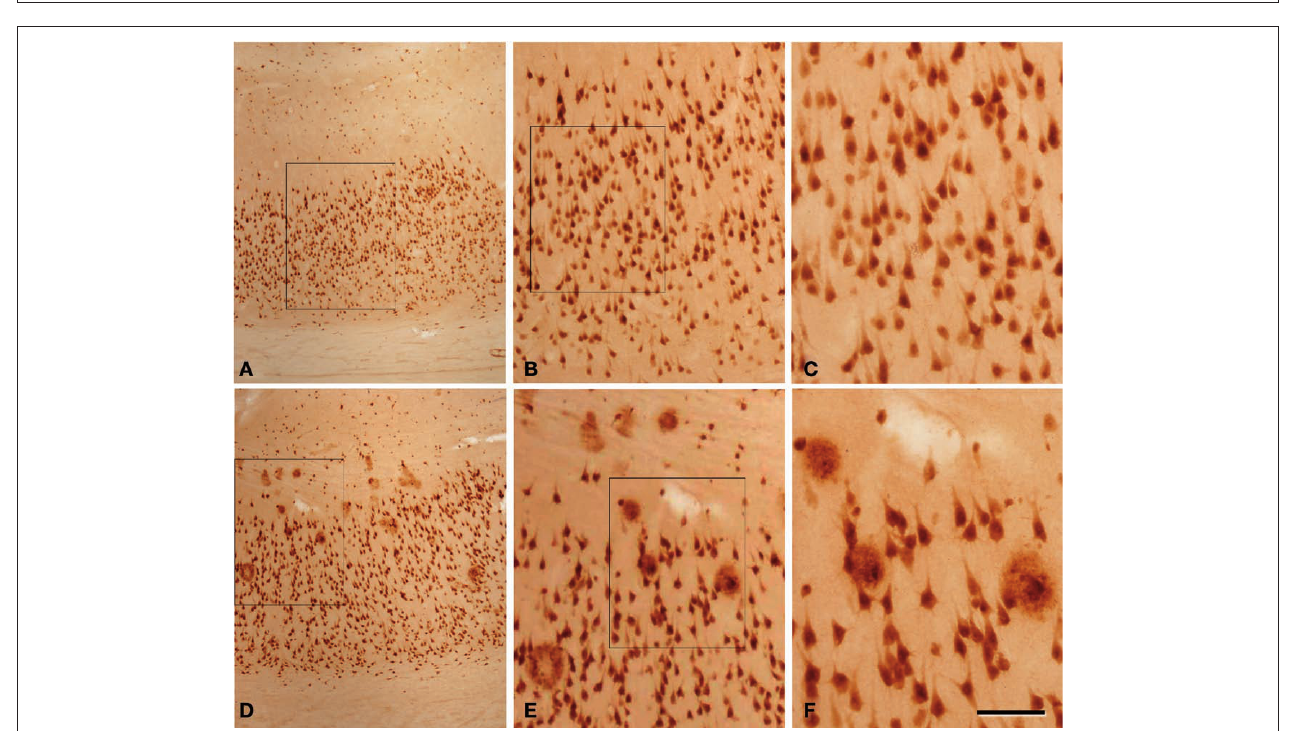
matter in (A) , respectively. Arrows in (B–E) point out plaques ( B–D ) or a neuron ( E ) also shown at higher magnifi cation in (F–I) , respectively. Note that in the superfi cial white matter (C,D) there are numerous plaques, whereas in the deep white matter (E) no or very few plaques are present. ( F–H) Cored neuritic, diffuse and non-cored neuritic plaques, respectively. Scale bar, 100 µm in (A) ; 50 µm in (B–E) ; 25 µm in (F–I) .